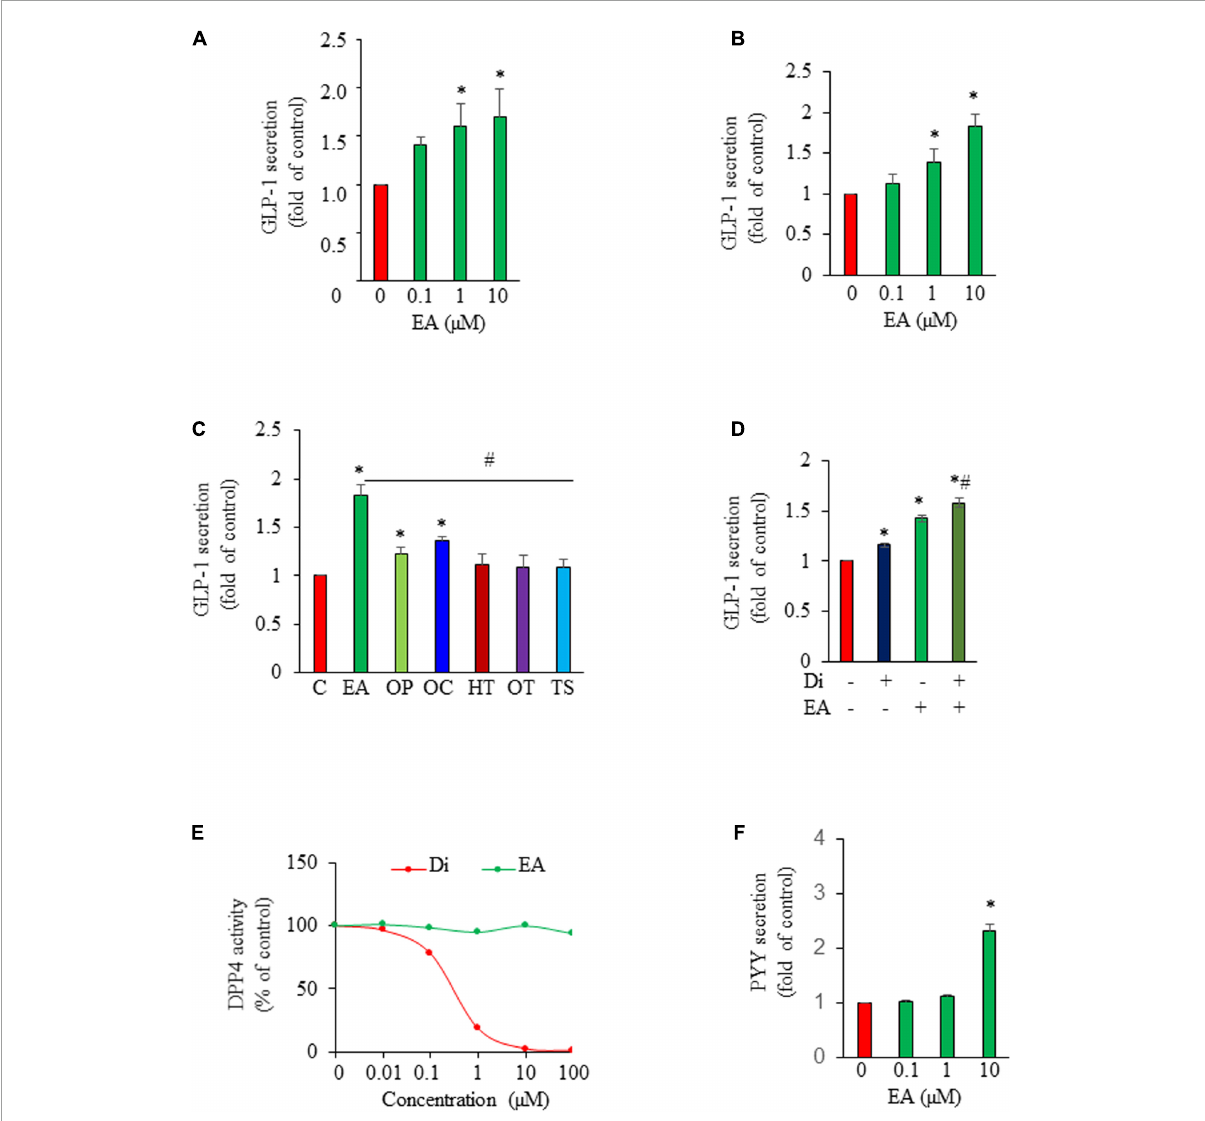
FIGURE1 Elenolic acid (EA) induces both glucagon-like peptide-1 (GLP-1) and peptide YY (PYY) secretion from L-cells. GLUTag L-cells (A) or mouse ileum crypts (B) were incubated with various concentrations of EA or vehicle for 1 h. GLP-1 secreted into medium was measured by ELISA, and the GLP-1 secretion was normalized to protein content of each treatment and converted to the percentage of the control. (C) GLP-1 secretion from cells treated with 10 µ M EA, oleuropein (OP), oleacein (OC), hydroxytyrosol (HT), oleocanthal (OT), or tyrosol (TS) for 1 h. (D) GLUTag cells were pre-incubated with or without DPP4 inhibitor vildagliptin (Di; 50 µ M) for 30 min and then treated with vehicle or 10 µ M EA for another 1 h. Supernatants were collected for GLP-1 secretion measurement. (E) The DPP4 activity in the presence of EA or DI was analyzed using a fluorescence reader at an excitation wavelength of 360 and emission wavelength of 465. (F) NCI-H716 L-cells were incubated with EA or vehicle for 1 h. PYY released into supernatants were measured using an assay kit. Data are mean ± SEM ( n = 3–4). ∗ p < 0.05 vs. control; # p < 0.05 vs.